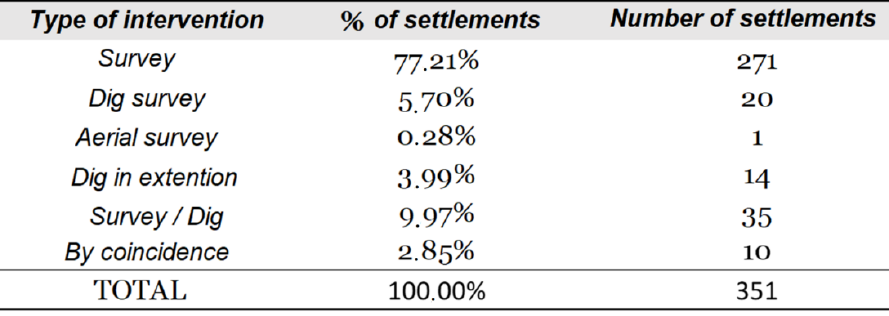
Figure 1. Of interventions carried out in the rural sites of my corpus. Own elaboration.